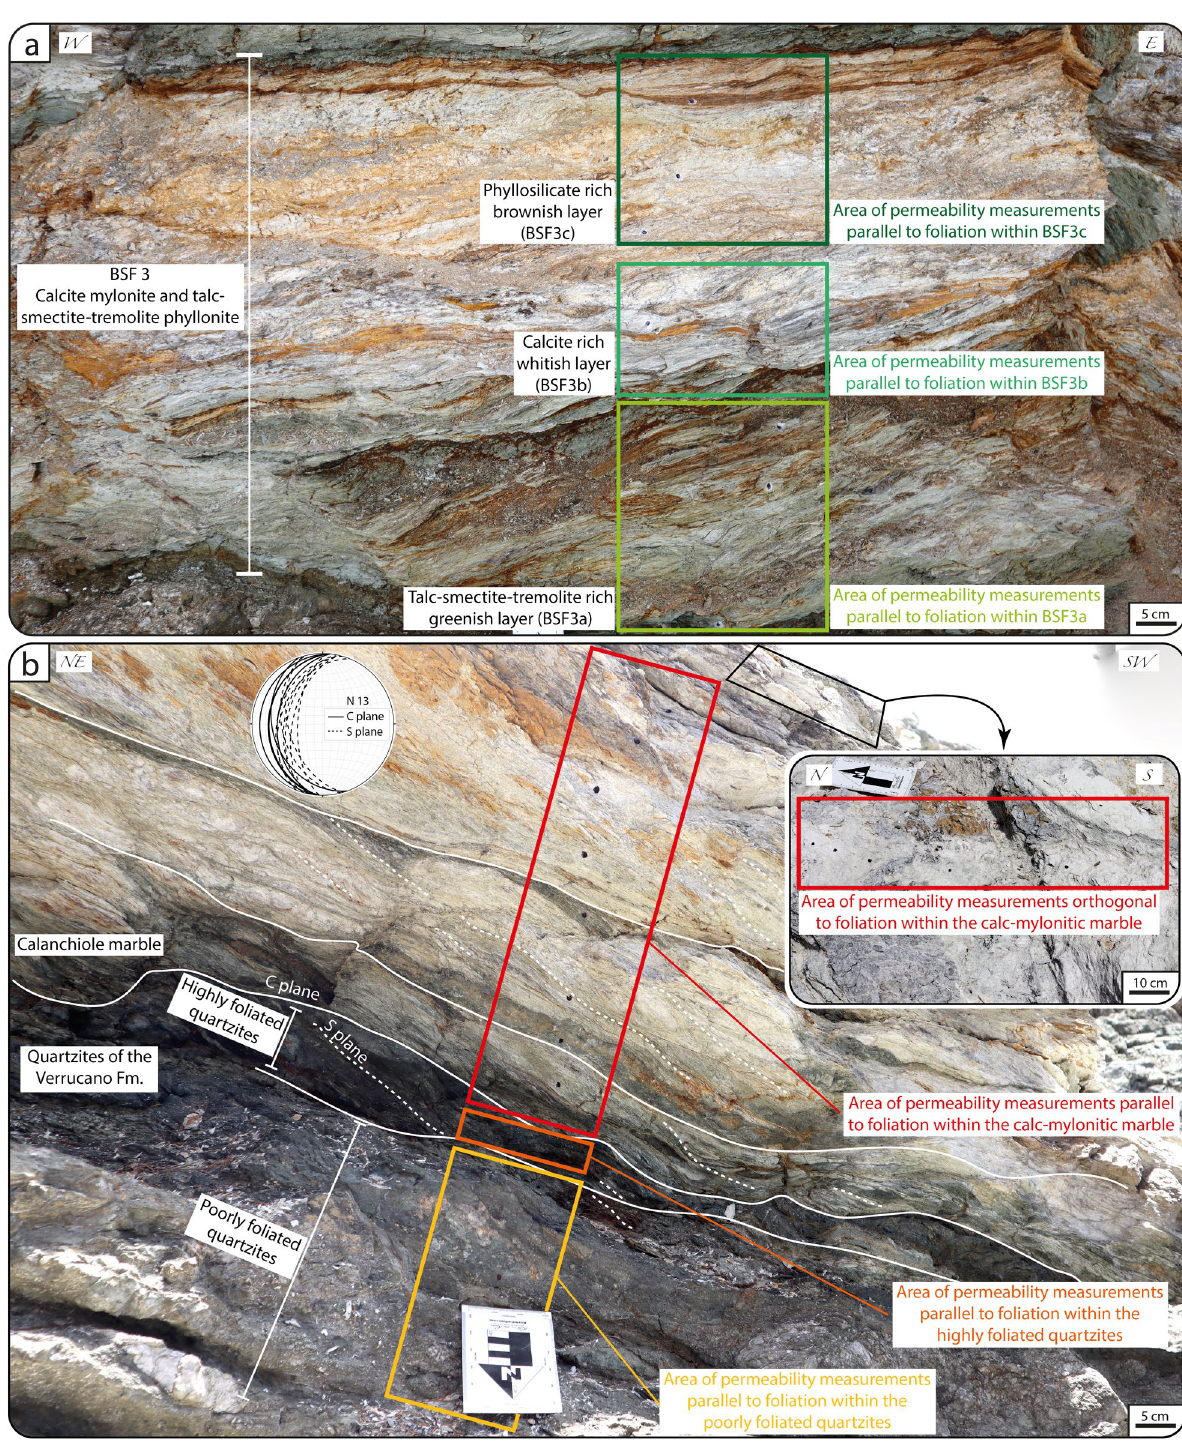
Figure 5. ( a ) BSF3 characterized by greenish (BSF3a), whitish (BSF3b), and brownish (BSF3c) layers. ( b ) Quartzites of the Verrucano Fm. and overlying Calanchiole marble. The quartzites are characterized by a lower poorly foliated portion and an upper highly foliated portion. The tectonic foliation within the Calanchiole marble is shown and plotted within the Schmidt net (lower hemisphere